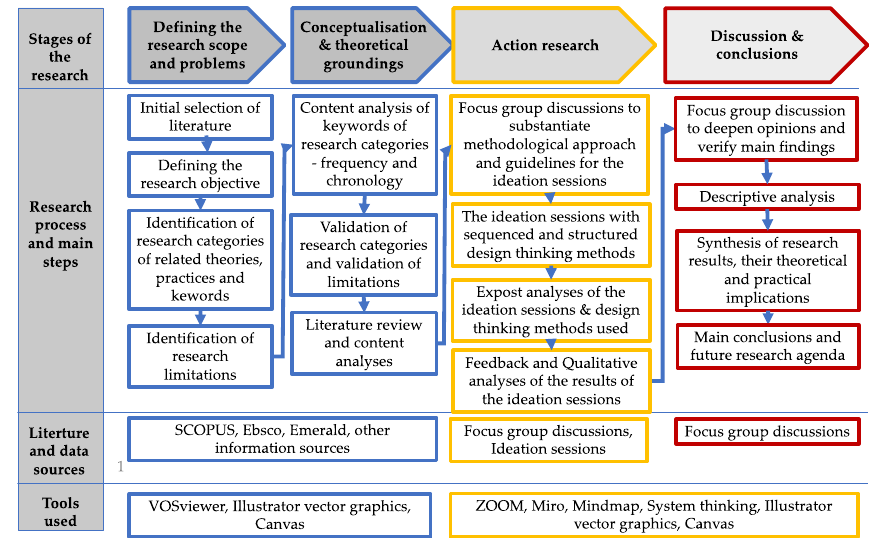
Fig. 4 The methodological framework of this research (source: the